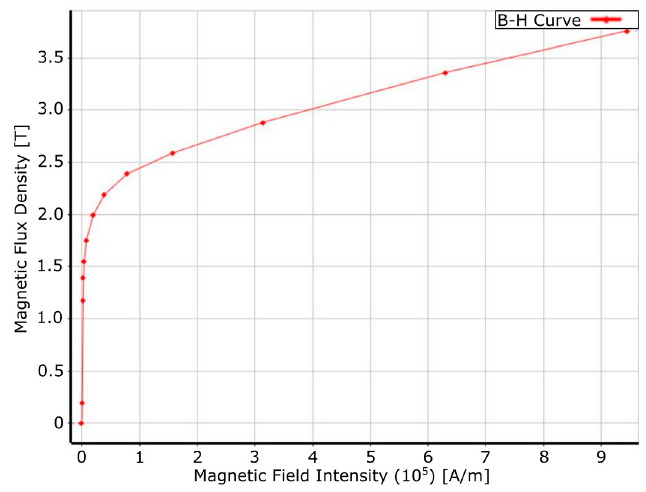
Figure 5. Curve of primary magnetisation of steel SA1020 used of the magnetic core cramp.